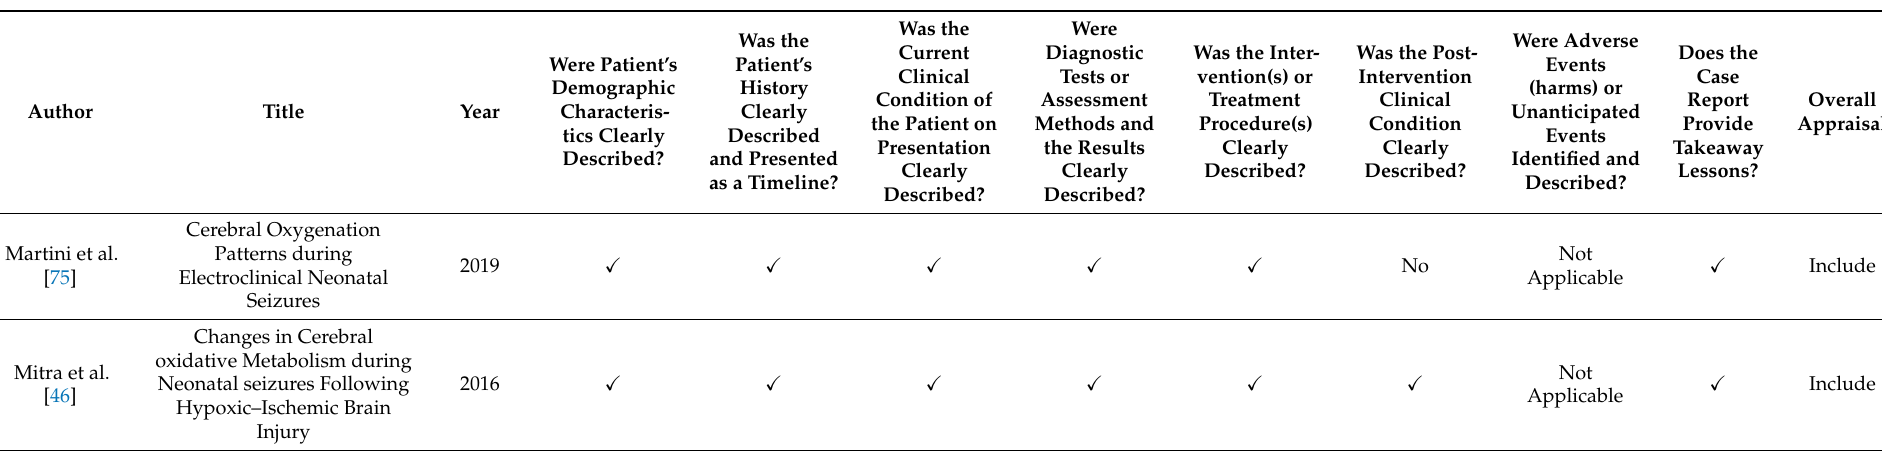
Table A2. Joanna-Briggs Institute appraisal of included case